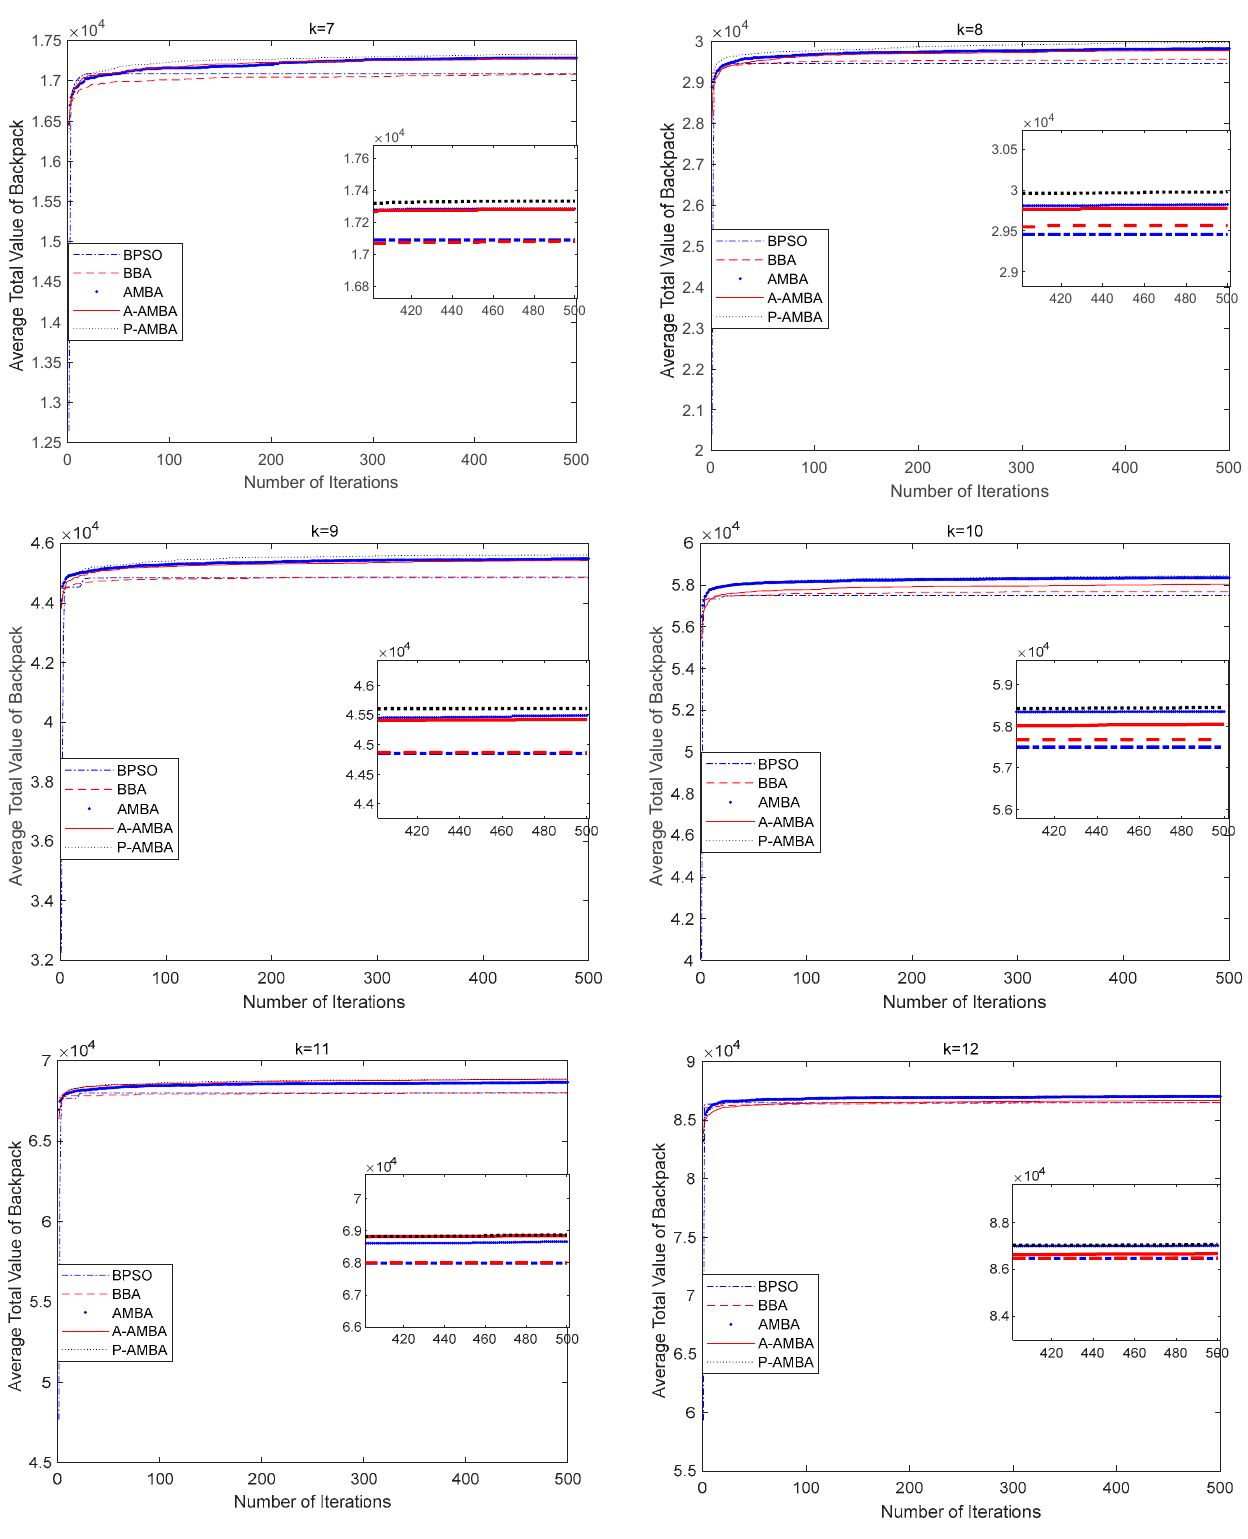
Figure 5. Average convergence curves of BPSO, BBA, AMBA, A-AMBA, and P-AMBA on some selected large-scale problems over 30 independent runs.